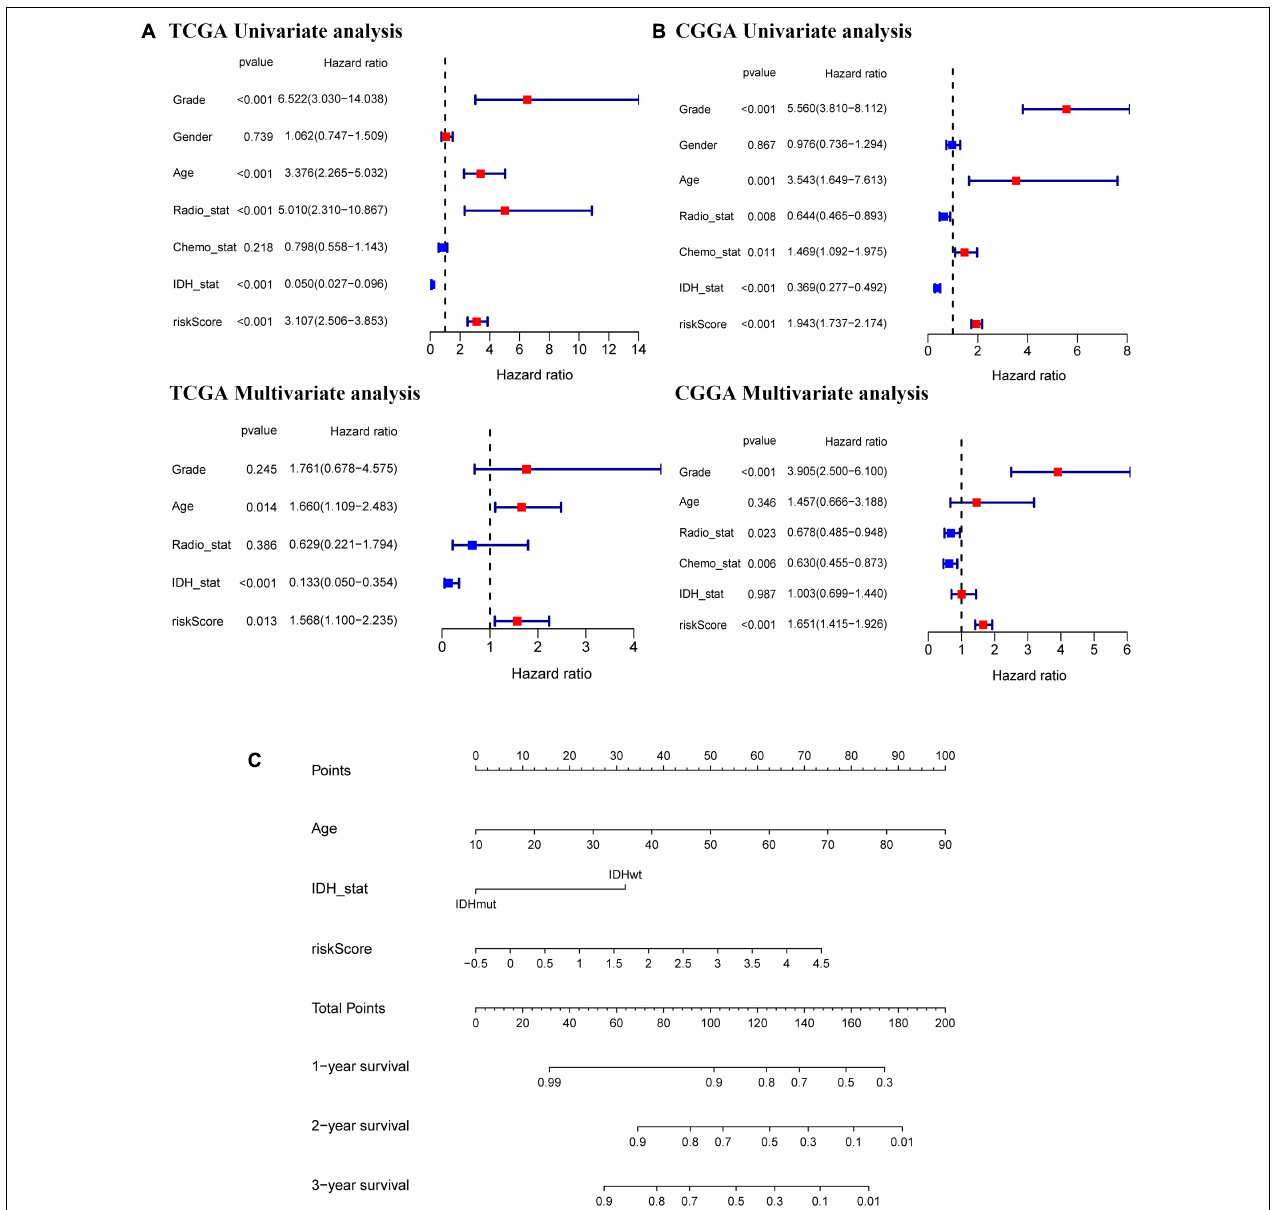
FIGURE 6 | Independent prognostic value of the 11-gene signature in the TCGA and CGGA cohorts and construction of the predictive nomogram from the CGGA cohort. Univariate and multivariate Cox regression analyses of the signature in the TCGA derivation cohort (A) and the CGGA validation cohort (B) . (C) A nomogram of the 11-gene signature for predicting 3-year survival in the TCGA